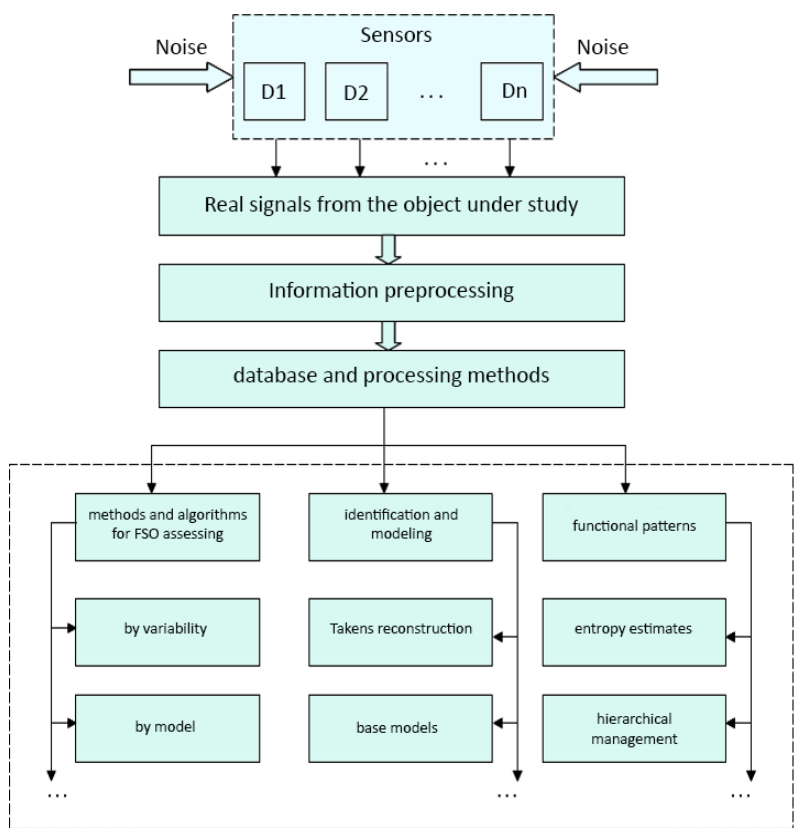
Fig. 2. An example of directions and methods of using biosignals in the form of time series for assessing human